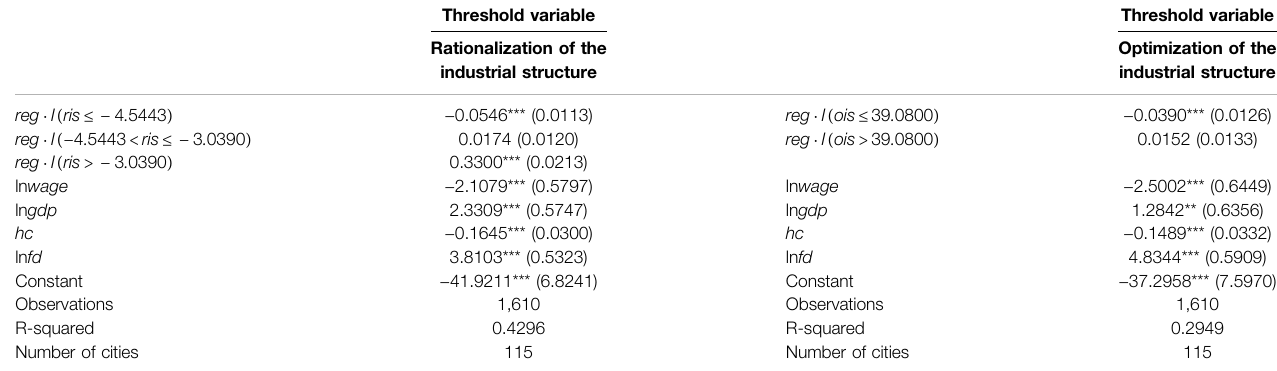
TABLE 4 | Parameter estimation results of the panel threshold